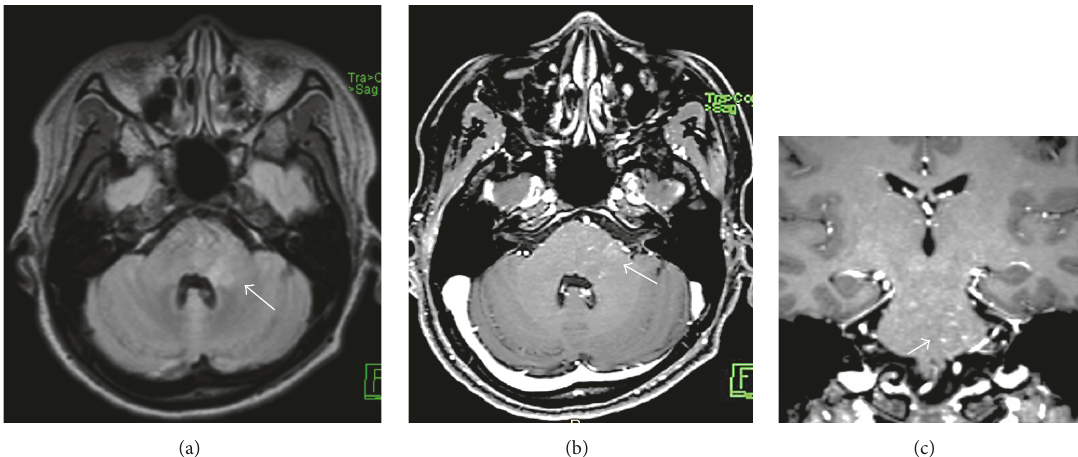
Figure1:(a)AxialT2/FLAIRand(b)axialandsagittal(c)T1weightedMRIafterIVgadoliniumbasedcontrastmediuminjection,showingill- defined faint bright intensity in the posterior pons and left brachium pontis (arrow in (a)) and characteristic punctate and linear enhancement (arrow in (b) and (c)).